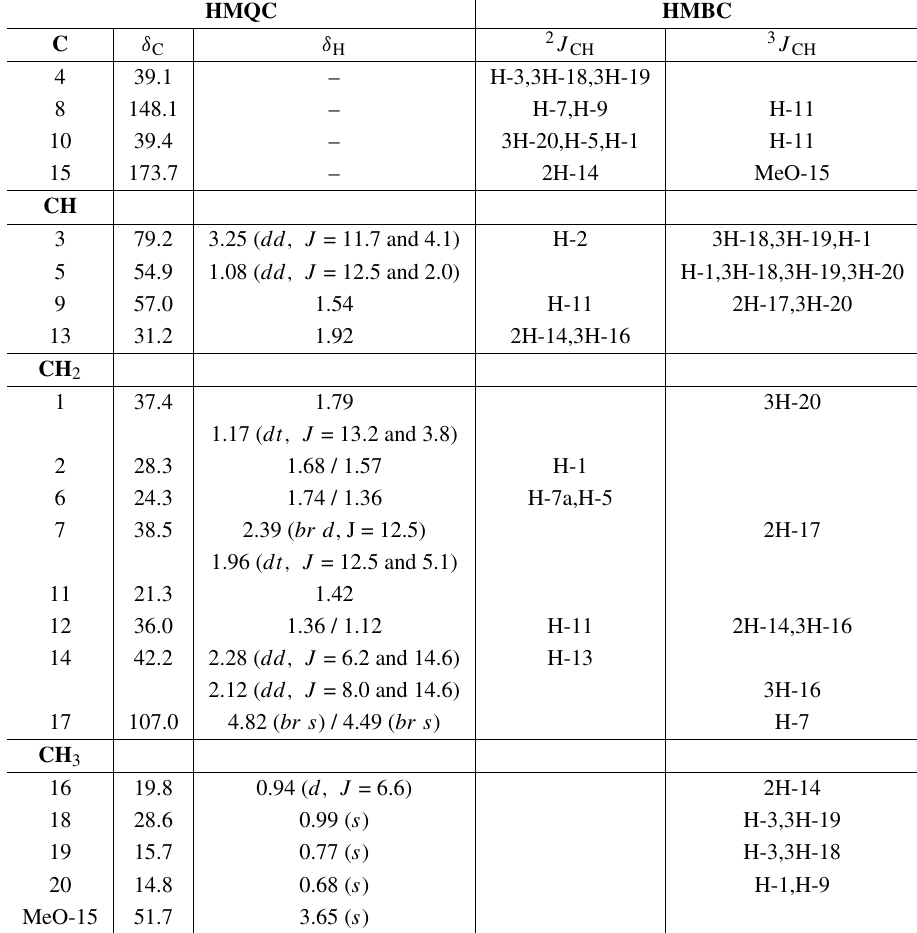
1 H (300 MHz) and 13 C (75 MHz) NMR spectral data for derivative 17 (CDCl of heteronuclear 2D experiments 1 H- 13 C-COSY- n J CH ( n=1, HMQC; n= 2 and 3,